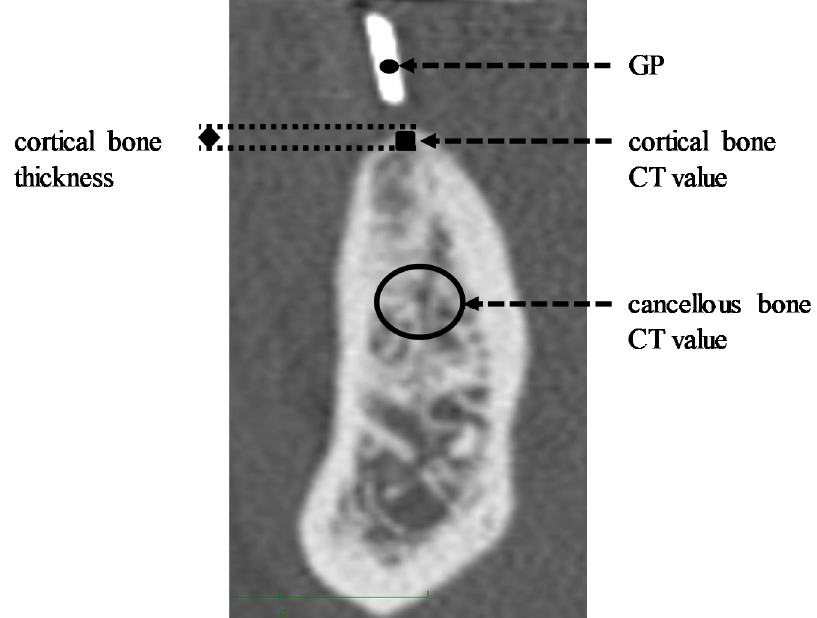
Figure 2. Computed tomography (CT) measurement methods. Gutta-percha point (GP): CT value at gutta-percha point. Cortical bone thickness: the thickness of cortical bone at alveolar crest. Cortical bone CT value: mean of 3 CT measurements of the cortical bone at alveolar crest. Cancellous bone CT value: mean CT value for 10 mm 2 ROI set in the cancellous bone.